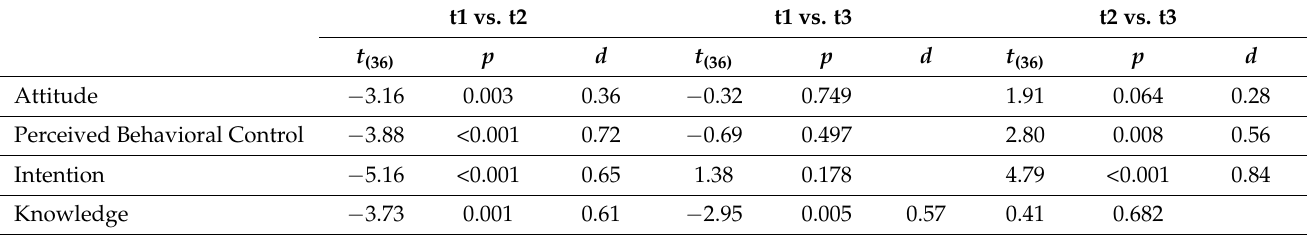
Table 3. Statistical values of the post-hoc t -tests for the subsample with all three points of measurement. t1 vs. t2 t1 vs. t3 t2 vs.